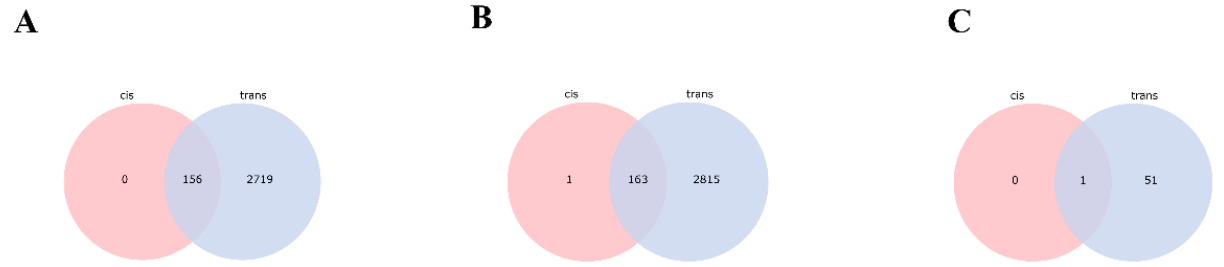
Figure 6. Trans/cis target gene prediction of 795 differentially expressed lncRNAs. ( A ) Venn diagram of cis/trans target genes of the PE vs. DE comparison group; ( B ) Venn diagram of cis/trans target genes of the PE vs. AE comparison group; ( C ) Venn diagram of cis/trans target genes of the DE vs. AE comparison group.